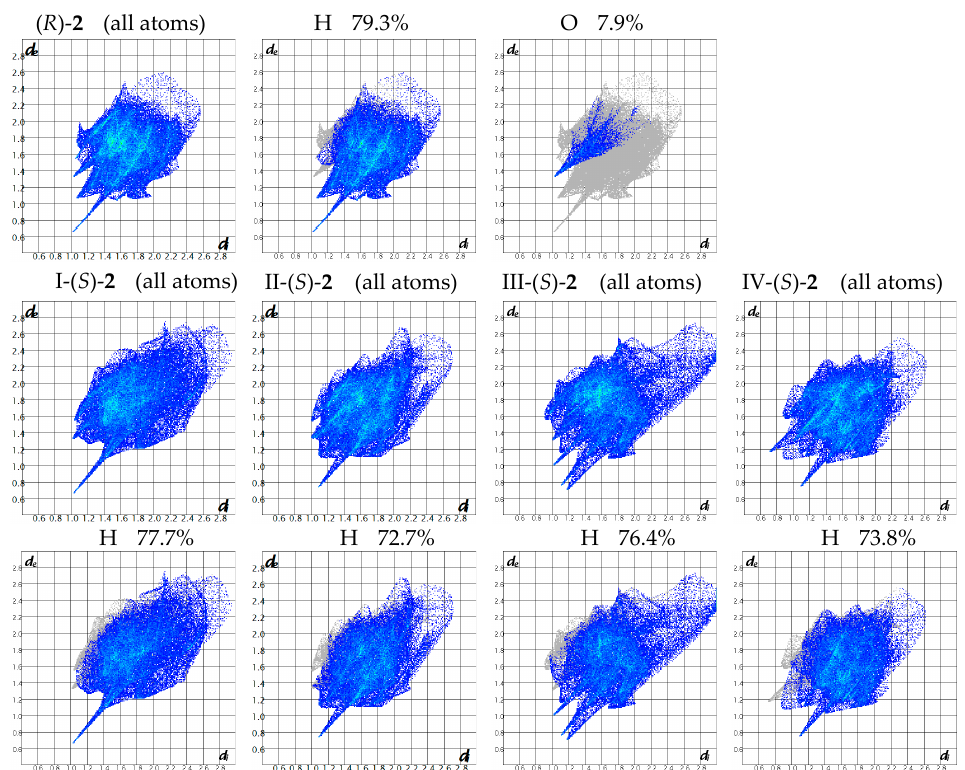
Figure 8 . The Hirshfeld surfaces (d norm ) for molecules ( R )- 2 and II-( S )- 2. The atoms with contacts shorter than the van der Waals radii are marked in red.